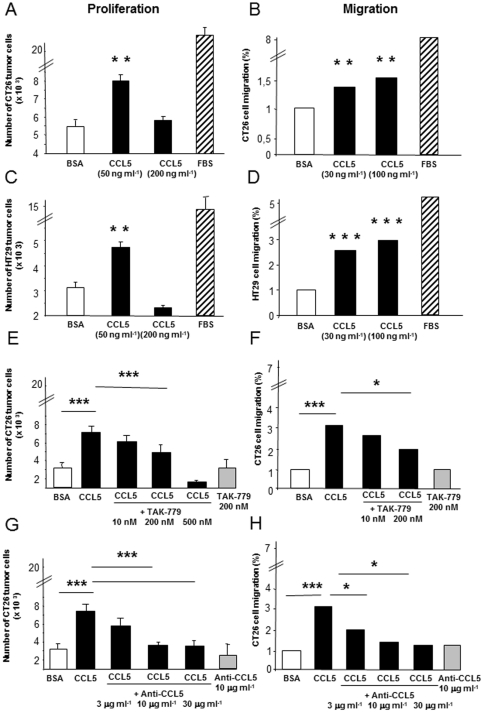
CCL5-induced tumor-promoting properties in CRC cells.(A, C, E, G) Proliferation of the CT26 and HT29 cells was assessed in response to a 5-day treatment with base medium alone (BSA, open bars), with serum-enriched medium (FBS, hatched bars) or with the indicated concentrations of recombinant CCL5 (filled bars), in the presence or in the absence of TAK-779 or anti-CCL5 antibodies (at the indicated concentrations). (B, D, F, H) CRC cells were assayed for chemotaxis in response to base medium alone (BSA, open bars), to serum-enriched medium (FBS, hatched bars) or to the indicated concentrations of recombinant CCL5 (filled bars), in the presence or in the absence of TAK-779 or anti-CCL5 antibodies. Results represent the mean±s.e.m. of six determinations. * p<0.05, ** p<0.01, *** p<0.001.